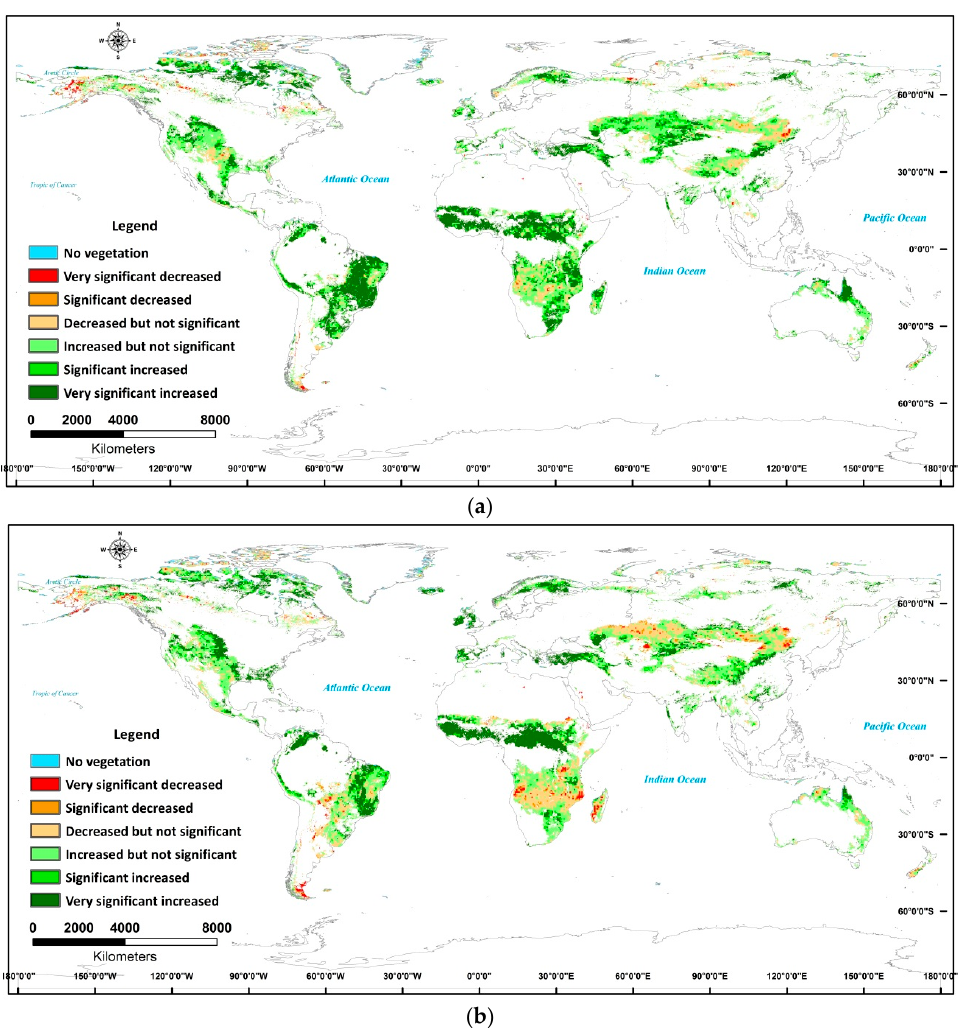
Figure 2. Spatial trends of annual maximum ( a ) and mean ( b ) NDVI in global OGFD ecosystems from 1982 to 2011. Table 1. The area proportion (%) of different change trends in the annual maximum and mean NDVI of global OGFD ecosystems from 1982 to 2011.